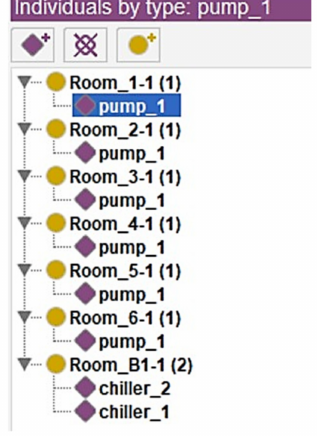
Figure 11. Example of the data reasoning